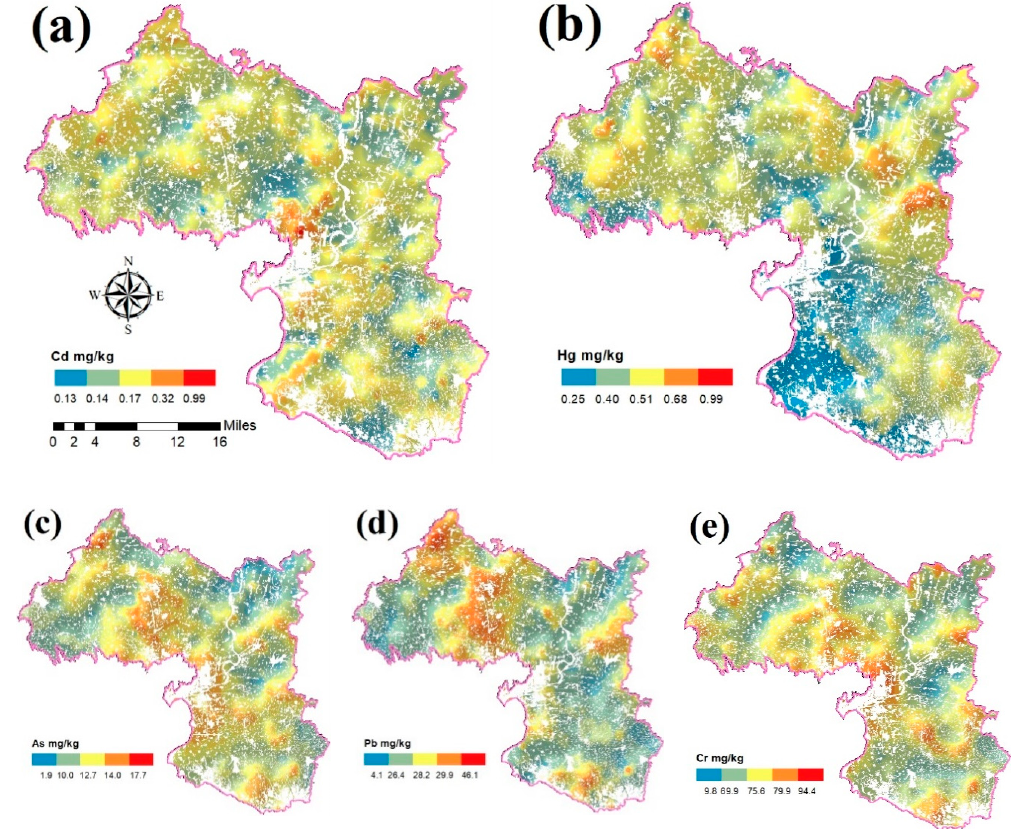
Figure 4. The spatial distribution of PTEs in the research region: ( a ) Cd; ( b ) Hg; ( c ) As; ( d ) Pb; and ( e ) Cr. Table 3. Compendium statistics of concentrations of PTEs in soil at 1109 points in Xiangzhou. Cd